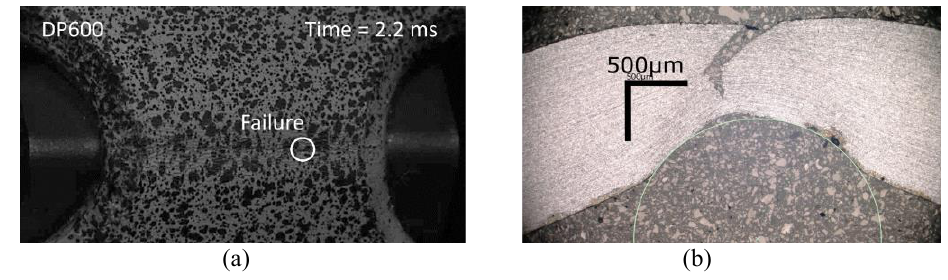
Fig. 4 . Free surface of a DP600 specimen at fracture (a). Through thickness optical micrograph of a DP600 specimen from an interrupted quasi-static test just before force